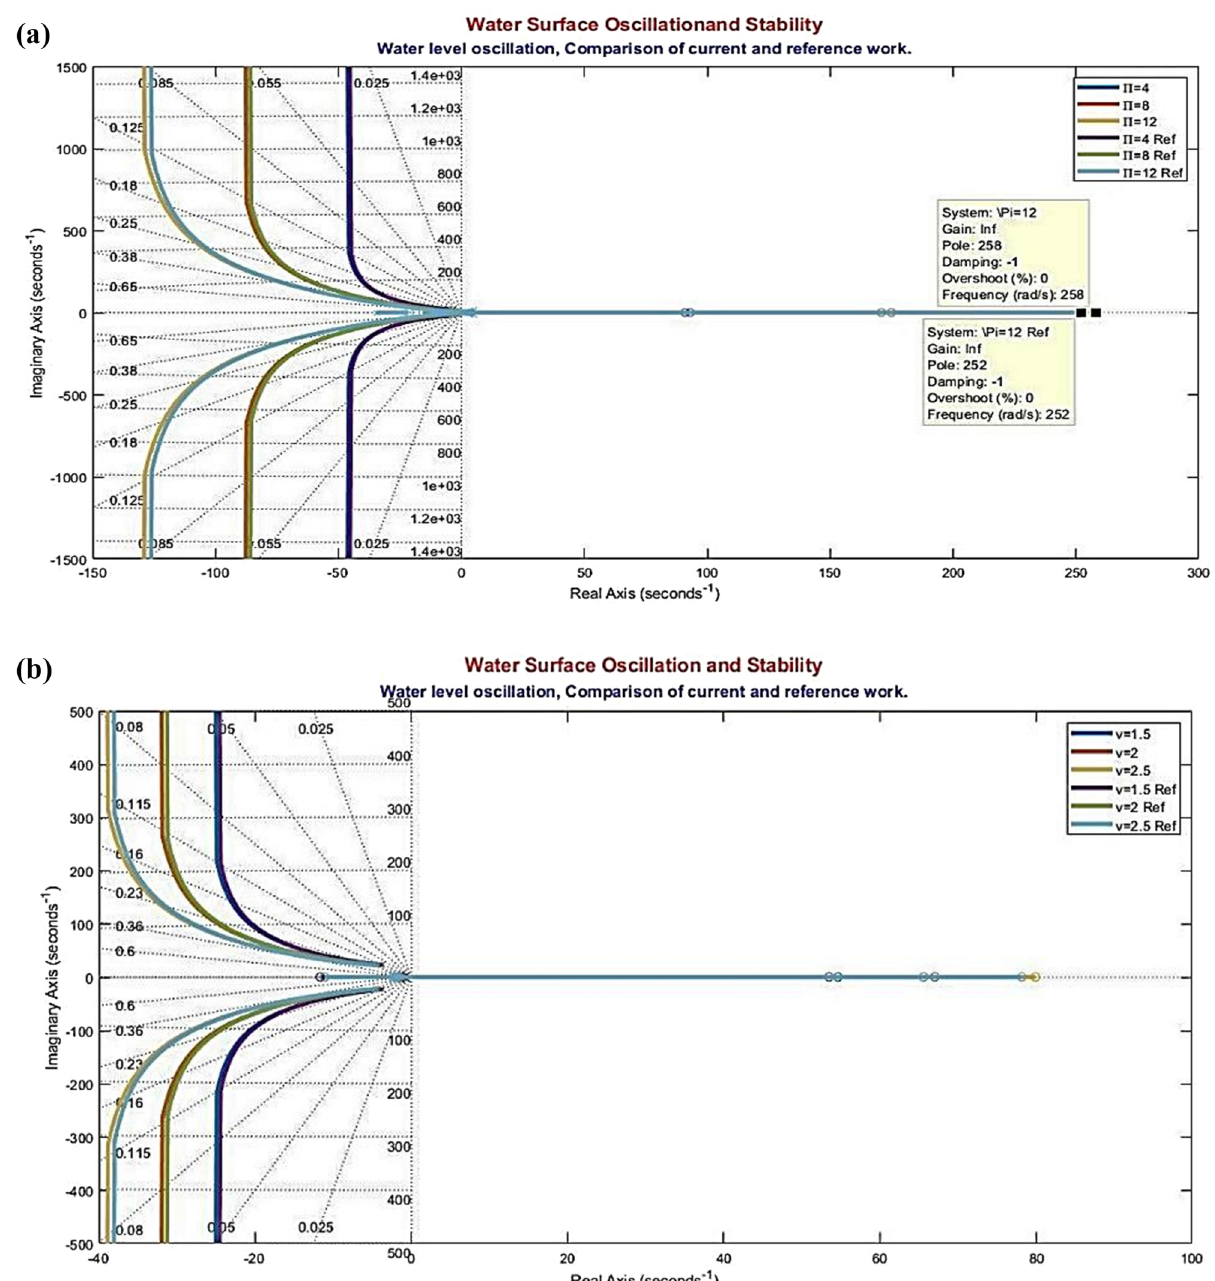
Figure 8: Validation of current work results and ref. [ 2 ] at ( a ) di ff erent pressure e ff ects and ( b ) di ff erent fl ow rate e ff